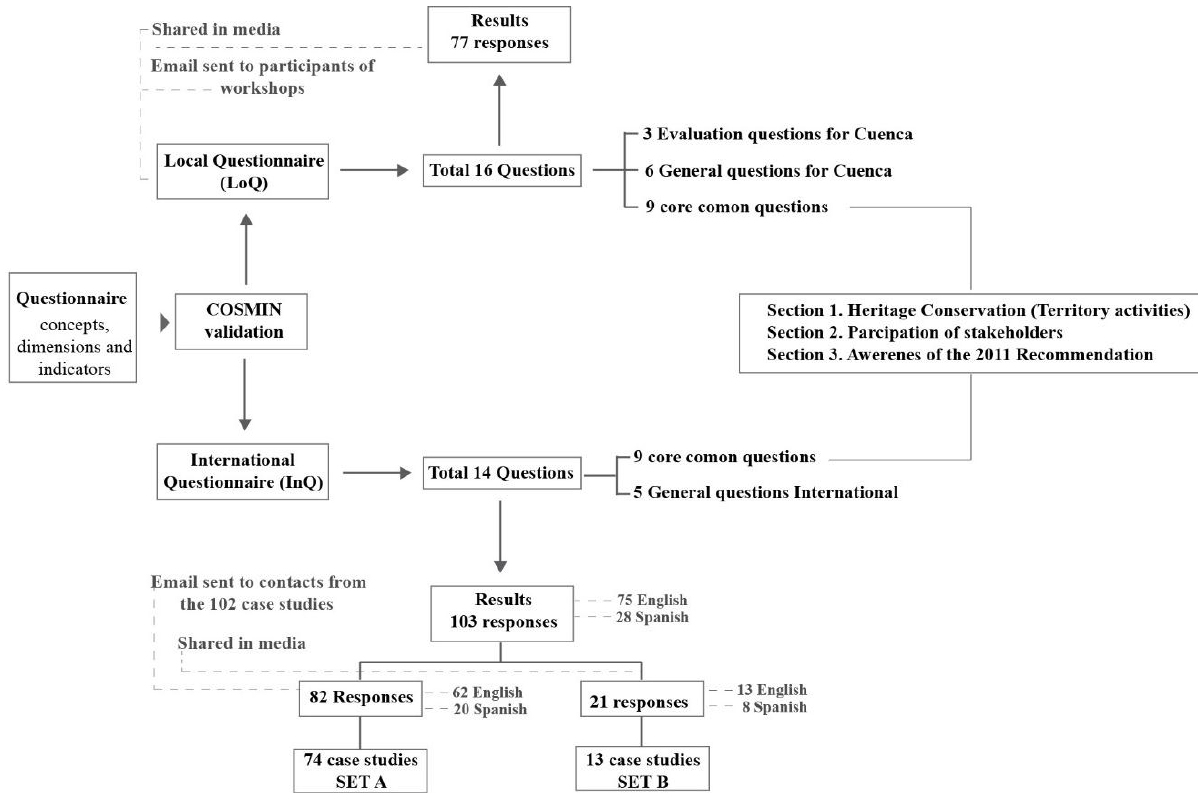
Figure 2. Scheme of the questionnaire proposed for local and international